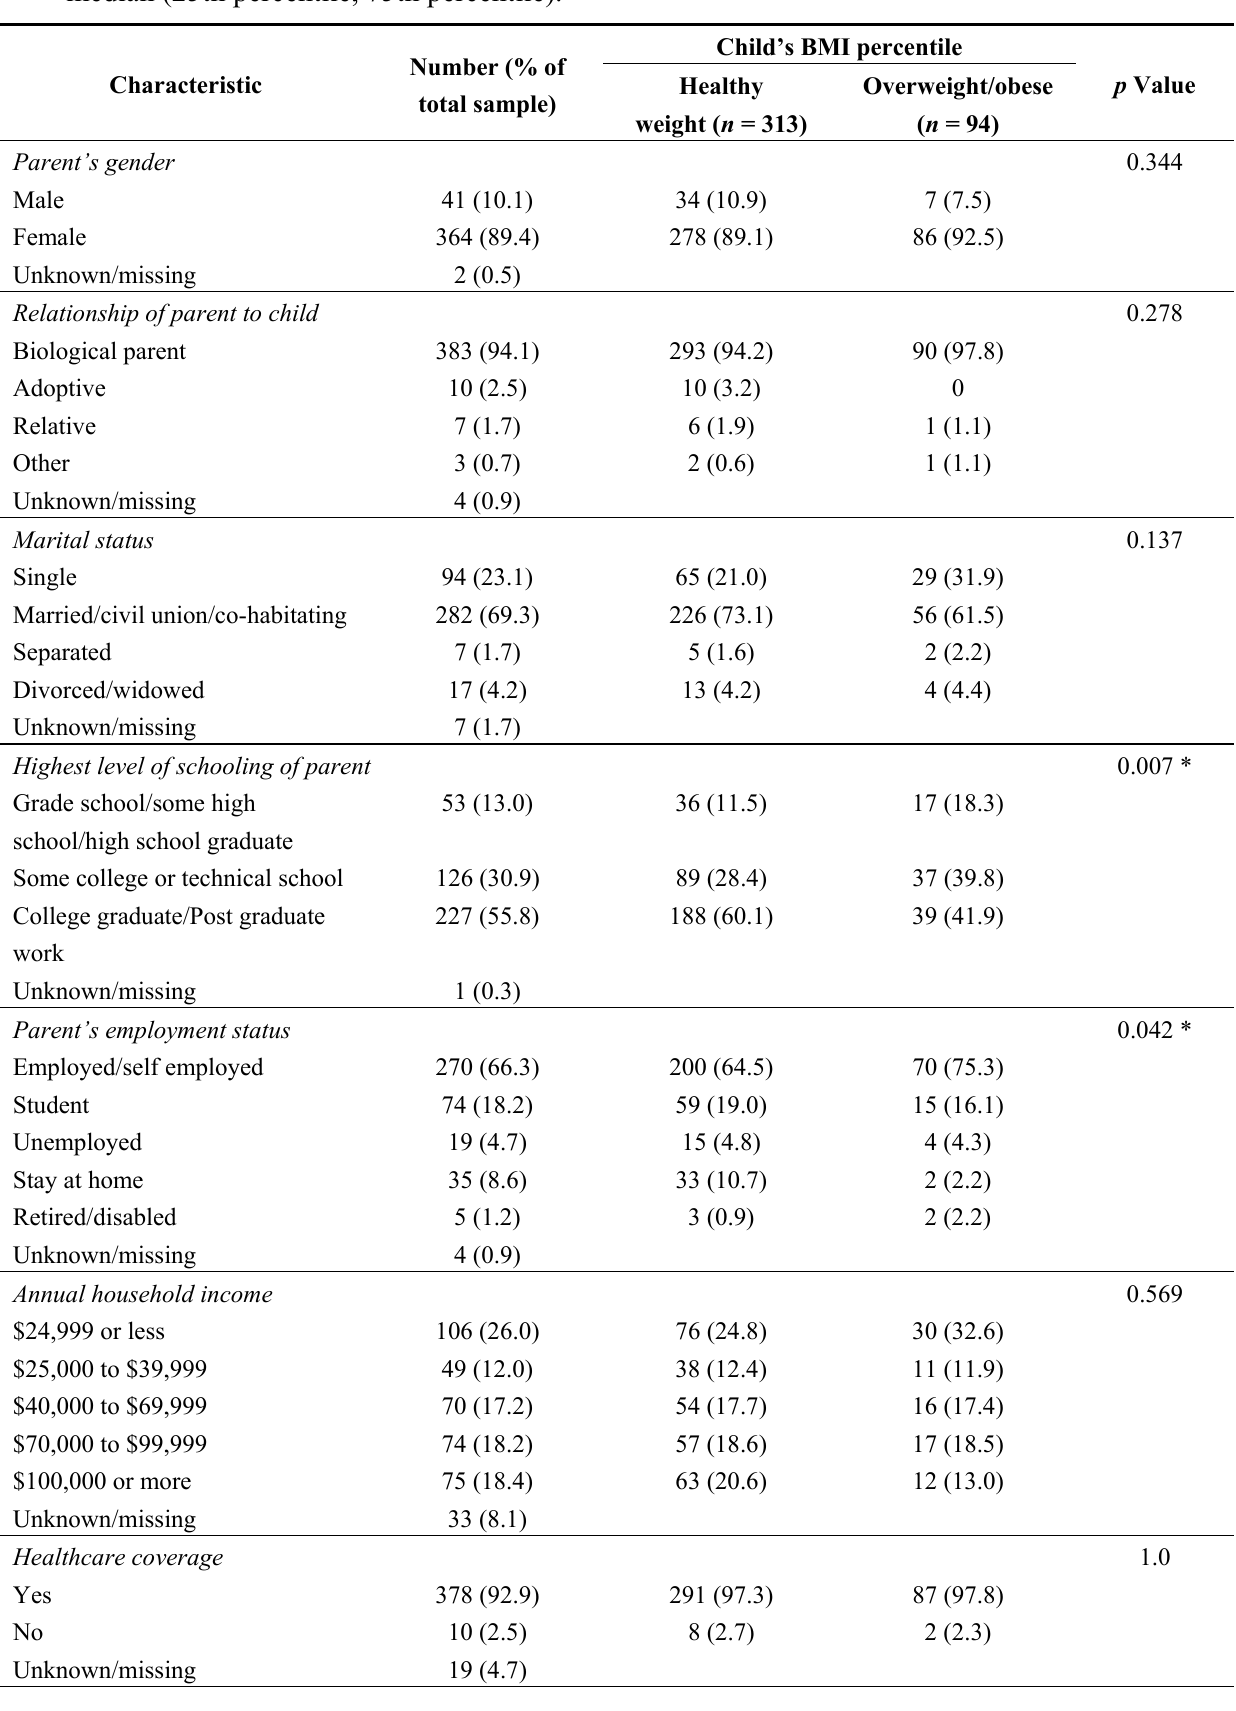
Table 1. Characteristics of the total study sample ( n = 407), shown as number (%) or median (25th percentile, 75th